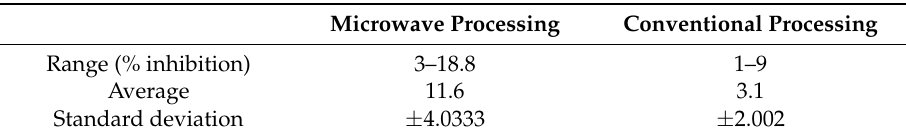
Figure 3. Effect of time (min) and temperature ( ◦ C) on trypsin inhibitor activity (TIA) of soymilk during microwave processing. Table 7. Summarized statistics for trypsin inhibition activity of soymilk processing using process parameters according to central composite